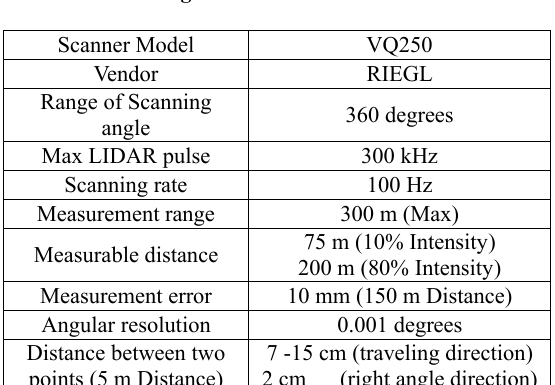
Figure 11 . MMS with MX-8